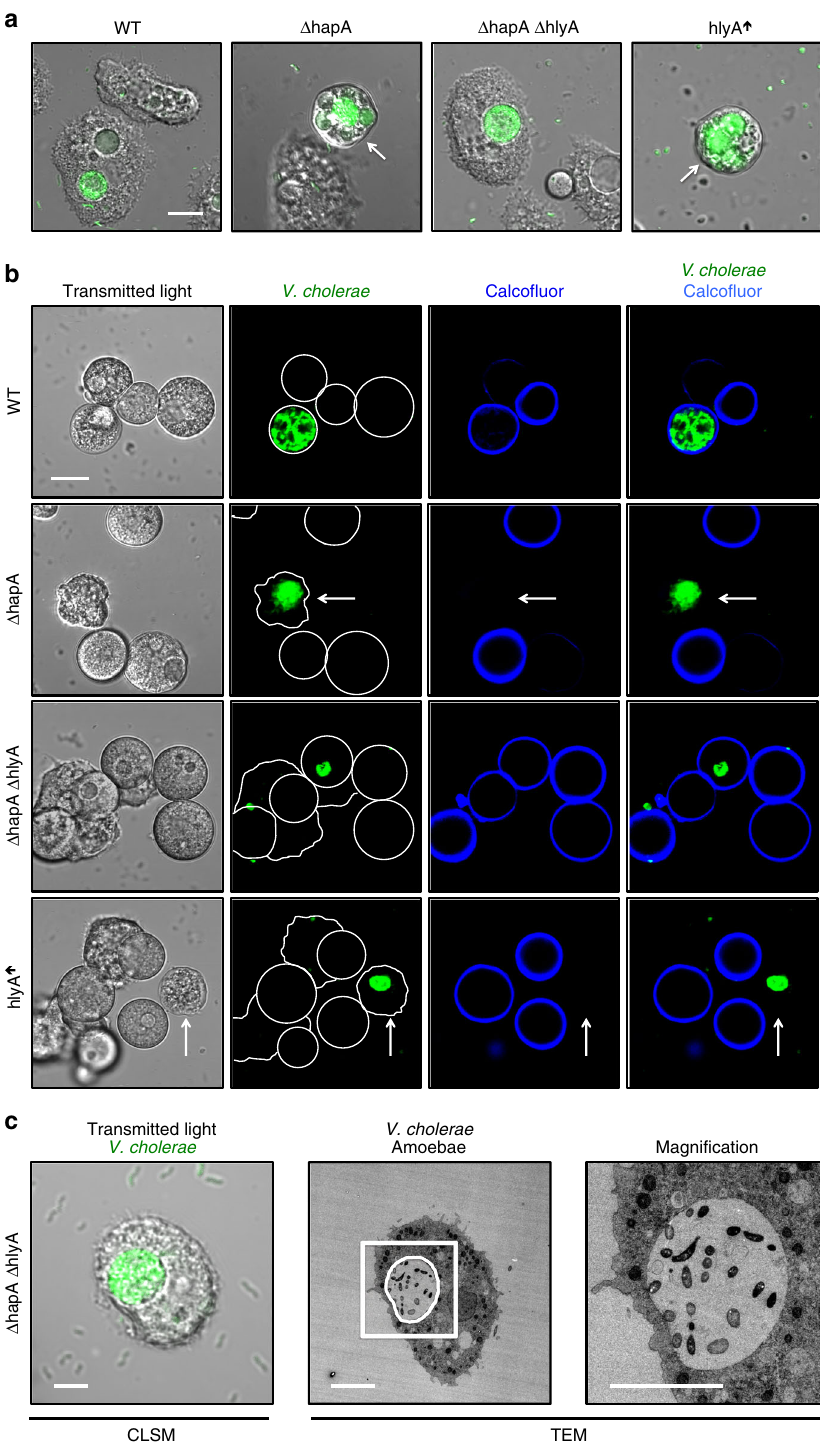
Fig. 3 Amoebal intoxication in hemagglutinin protease-de fi cient strains is caused by the PFT hemolysin (HlyA). a Aberrant amoebal morphotypes are caused by hemolysin (HlyA). Deletion of the hemolysin gene ( hlyA ) in the protease-minus V. cholerae strain ( Δ hapA Δ hlyA) nulli fi es intoxication of the amoebal trophozoites upon infection, while the latter is elicited through the overexpression of hlyA in the WT background (hlyA ↑ ). All of the bacterial strains were GFP-tagged. Merged images of the transmitted light channel and the green channel were taken at 20 h p.p.c. Aberrantly shaped amoebae are indicated by white arrows. Scale bar: 10 µ m b Absence of amoebal cellulose deposition is caused by hemolysin. A. castellanii cells were infected by the same V. cholerae strains as in a and, after staining with calco fl uor, imaged at 30 h p.p.c. White arrows depict colonized amoebae that are calco fl uor-negative and aberrantly shaped. Scale bar: 10 µ m. c CLEM image of an amoeba that is infected by the protease-de fi cient and hemolysin-de fi cient V. cholerae